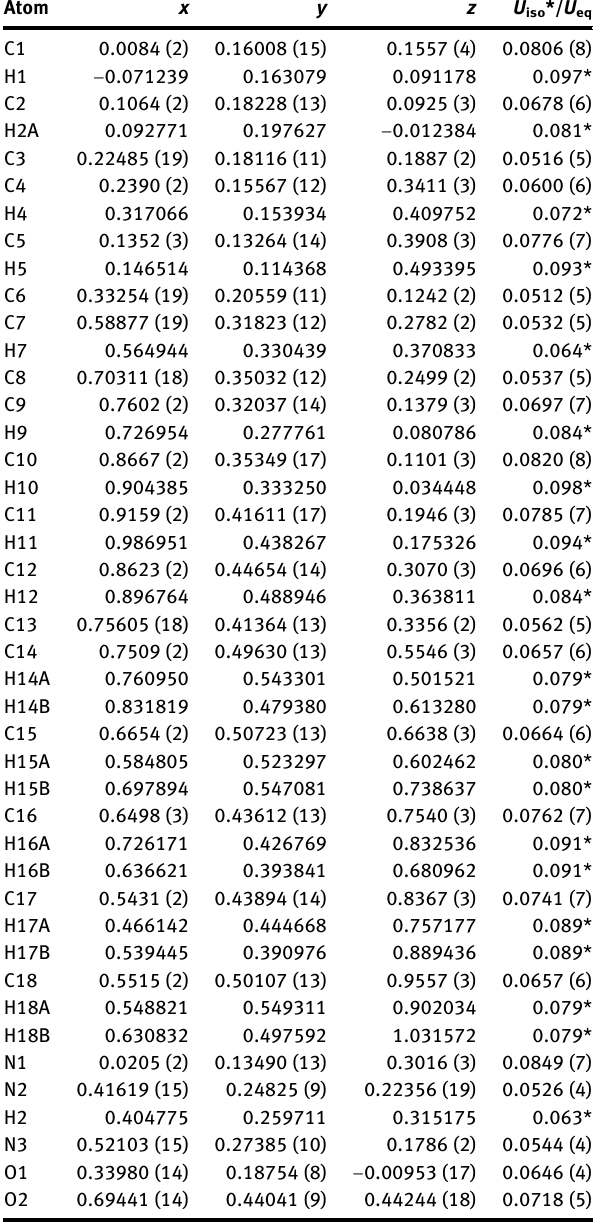
Table  : Fractional atomic coordinates and isotropic or equivalent isotropic displacement parameters (*/Å 